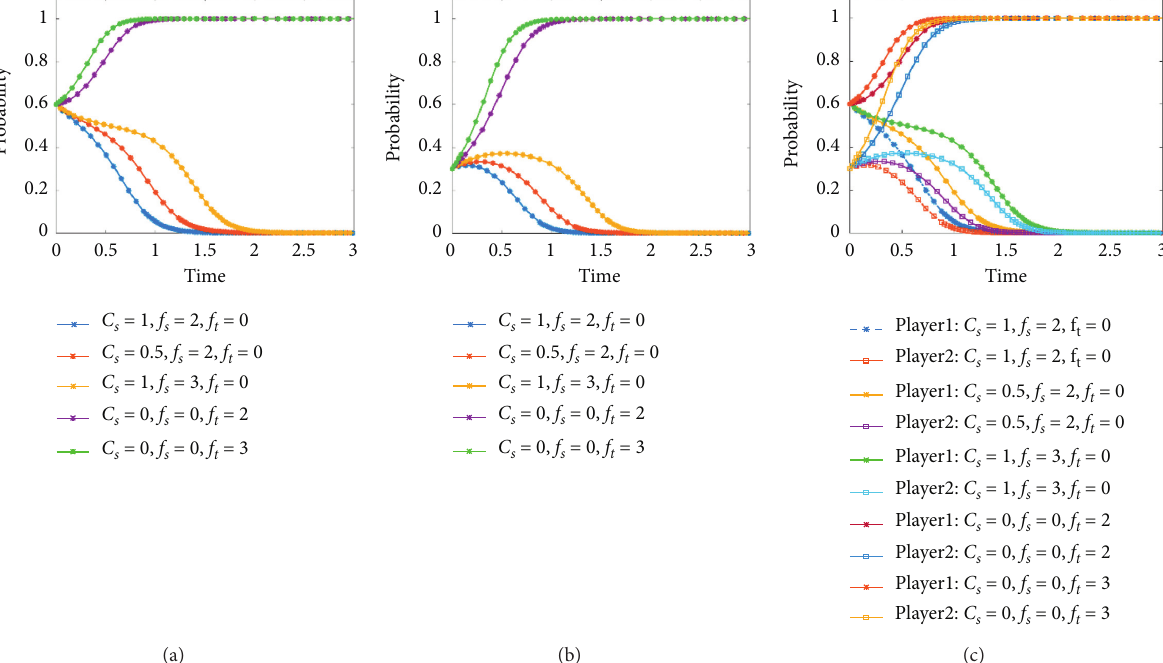
Figure 6: The dynamical evolutionary processes of the probability of knowledge sharing for five types of situations: ① with second-party punishment, c s � 1, f s � 2; ② with second-party punishment, c s � 0 . 5, f s � 2; ③ with second-party punishment, c s � 1, f s � 3; ④ with third-party punishment, f t � 2; ⑤ with third-party punishment, f t � 3. (a) The results for player1; (b) the results for player2; and (c) the results for both